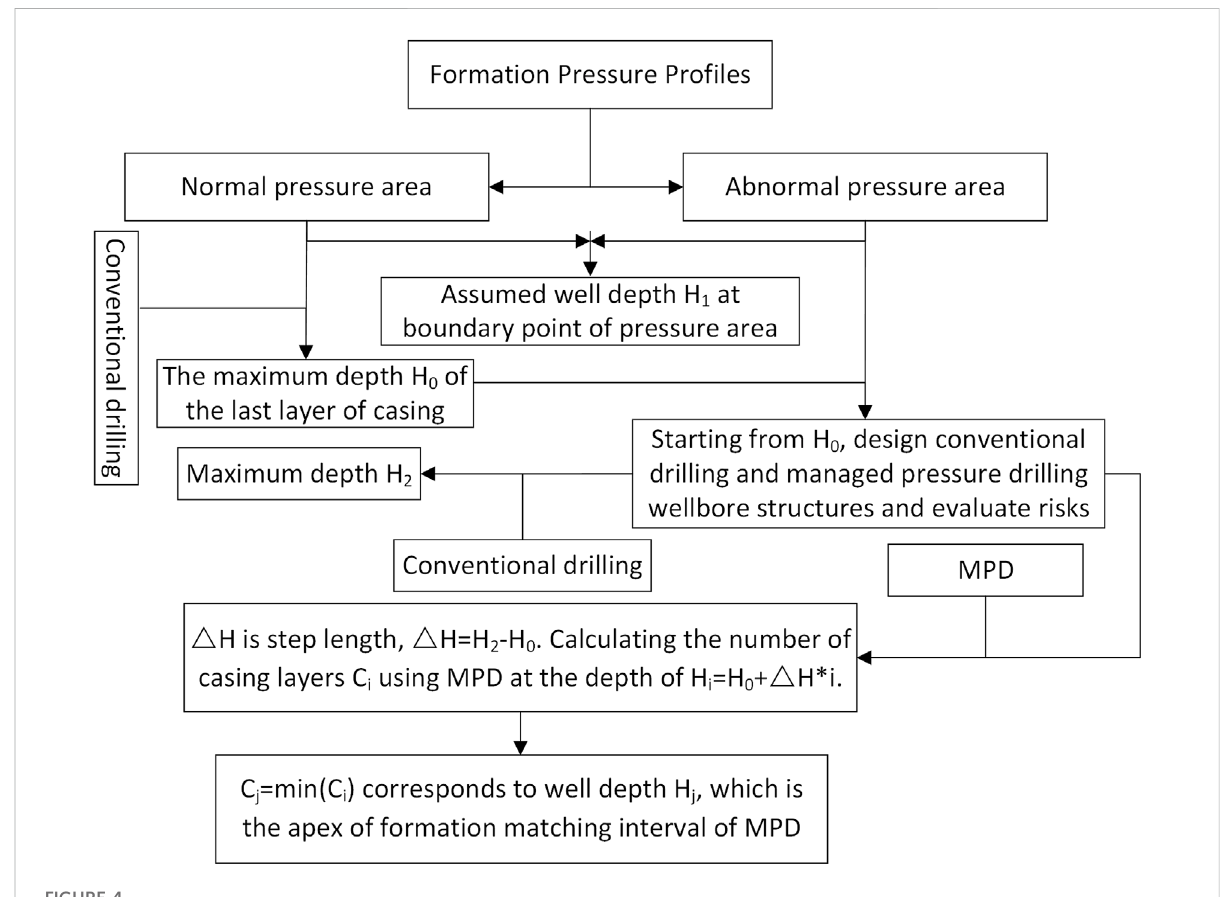
FIGURE 4 Flow chart of well structure optimization design of MPD based on arti fi cial bee colony